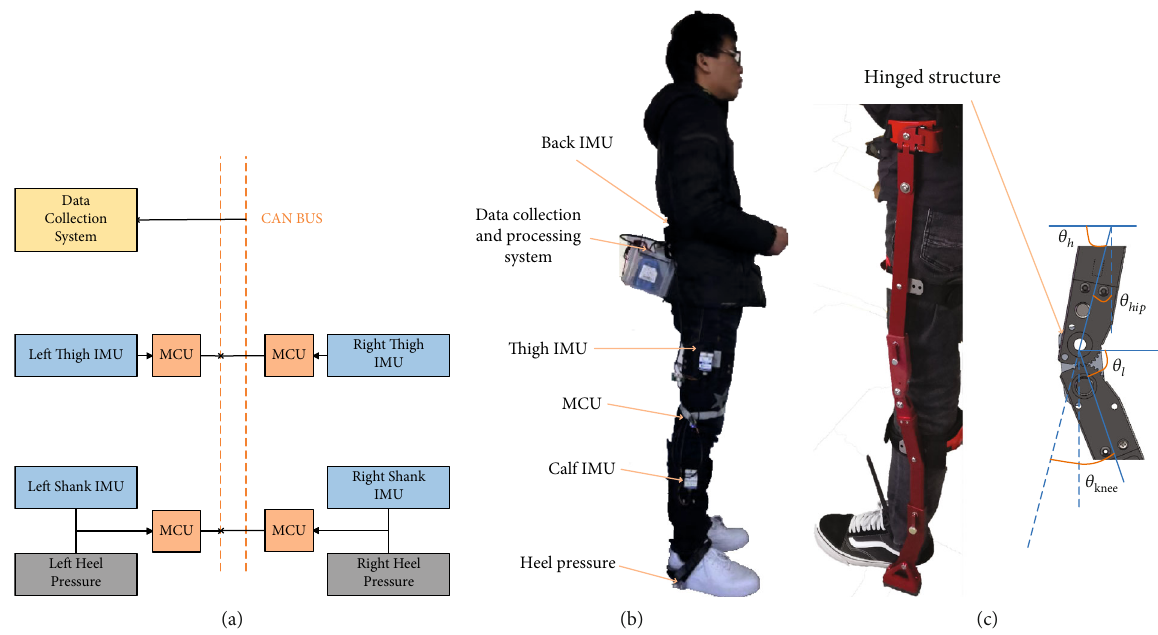
Figure 1: Motion capture system and exoskeleton structure. (a) Nets of the motion capture system. (b) Motion capture system. (c) Mechanical structure of the